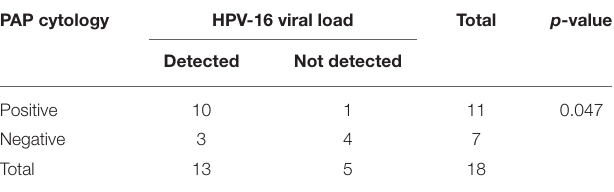
TABLE 5 | HPV-16 viral loads vs. Pap